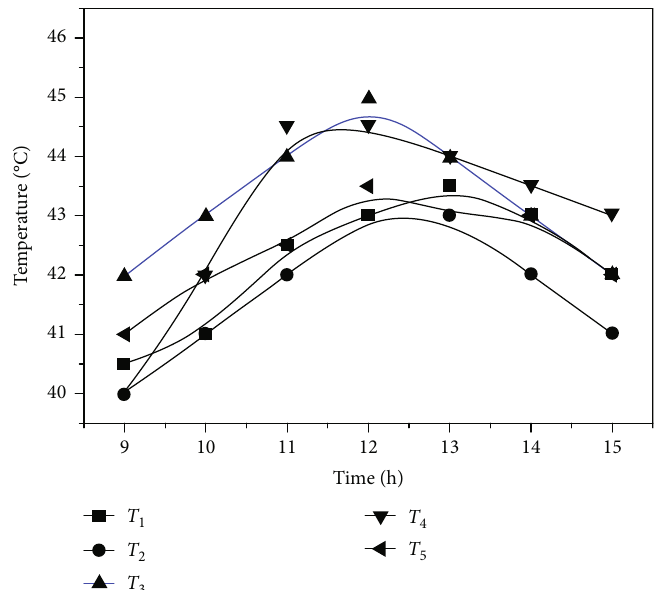
Figure 3: Evolution of module temperature.